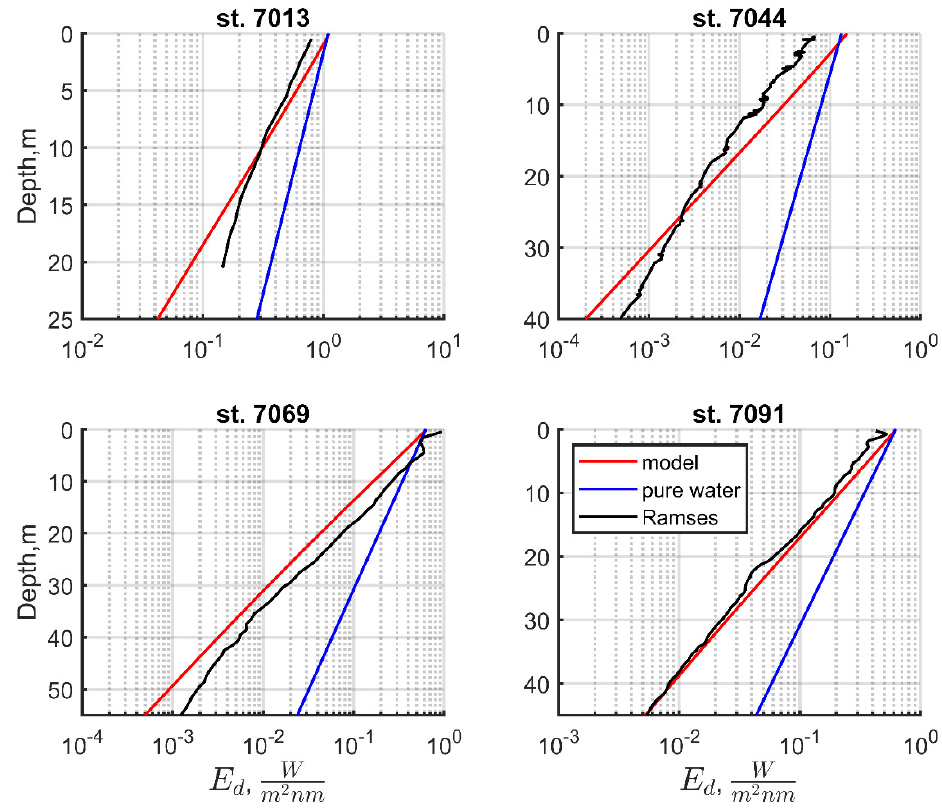
Figure 6. E d (530, z ) vertical profiles from direct measurements of Ramses (black lines), from modeling data taking into account OAC (red lines), and for a hypothetical case of pure water (blue lines).